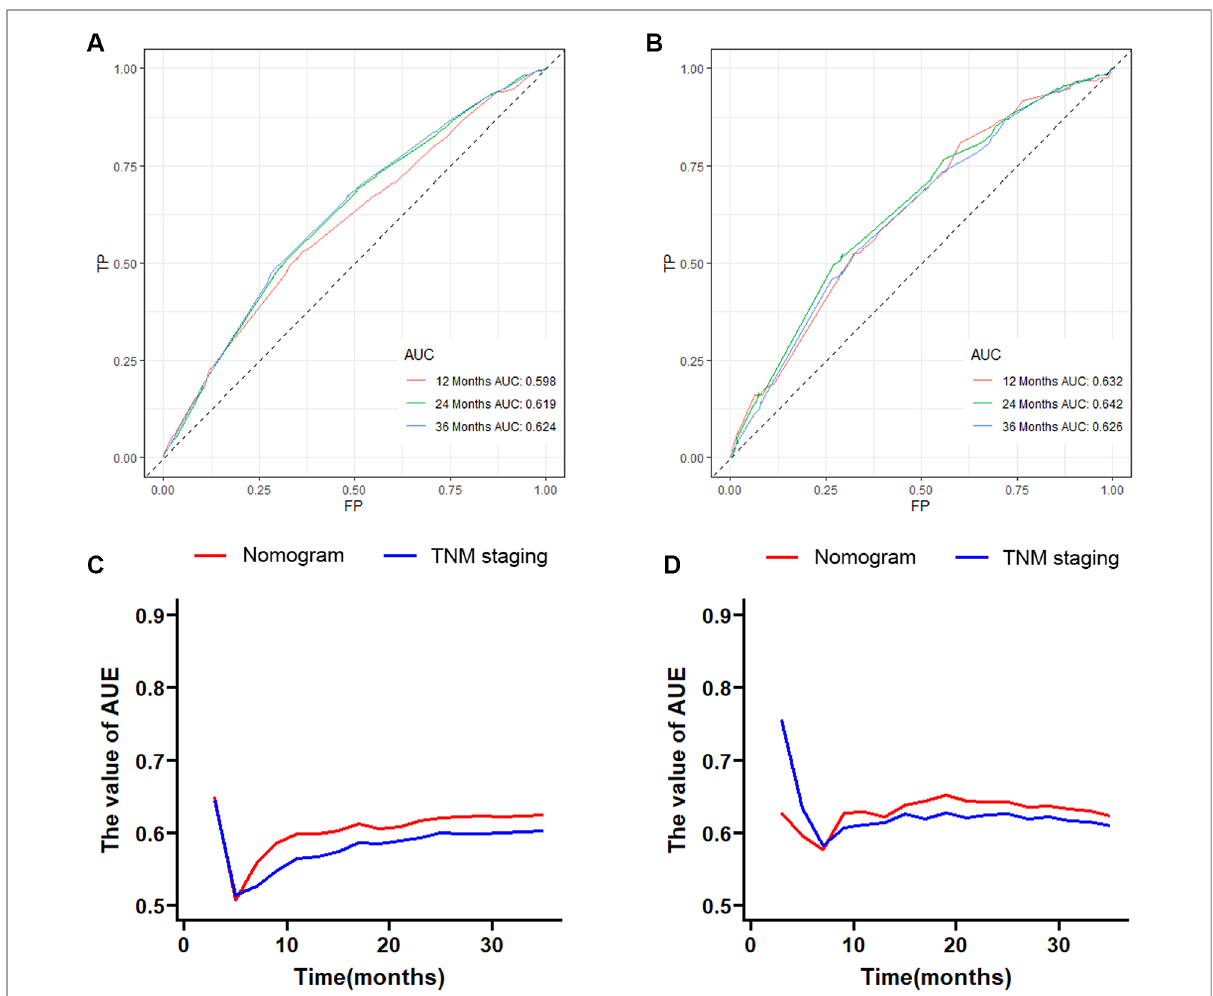
FIGURE 2 The 1-year, 2-year and 3-year ROC curves and area under the curve of the nomogram prediction model for predicting overall survival of esophageal cancer patients receiving neoadjuvant chemotherapy in the training cohort ( A ) and validation cohort ( B ); the time-dependent ROC curves in the training cohort ( C ) and validation cohort ( D ) were compared between the nomogram prediction model and traditional AJCC TNM